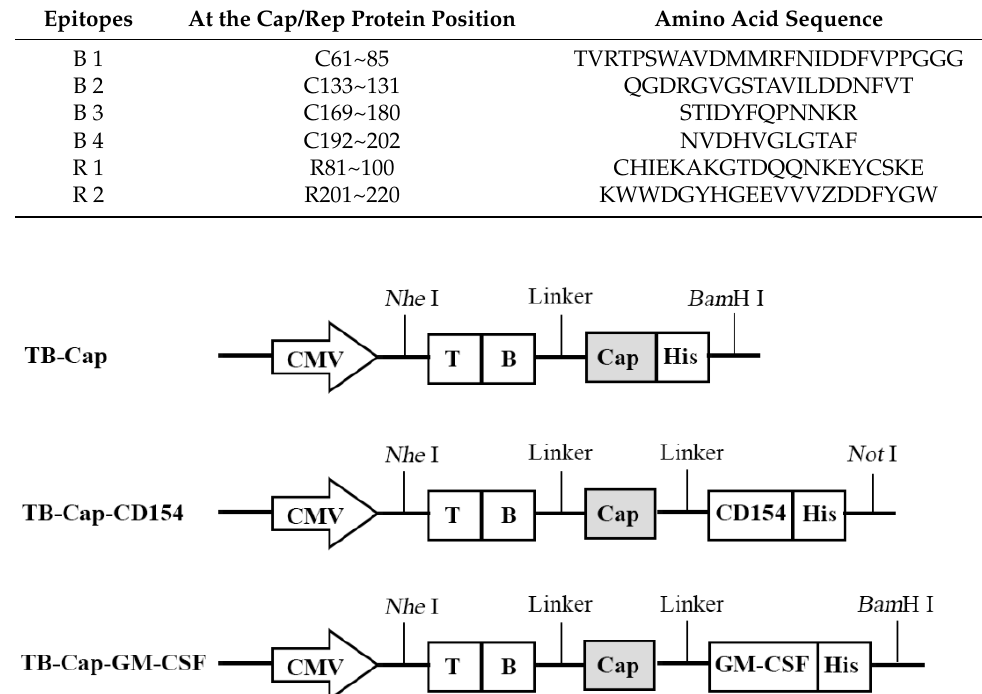
Figure 1. Schematic diagram of different recombinant genes. In order to improve the immunogen- icity of Cap protein, recombinant genes TB-Cap, TB-Cap-CD154 and TB-Cap-GM-CSF were de-